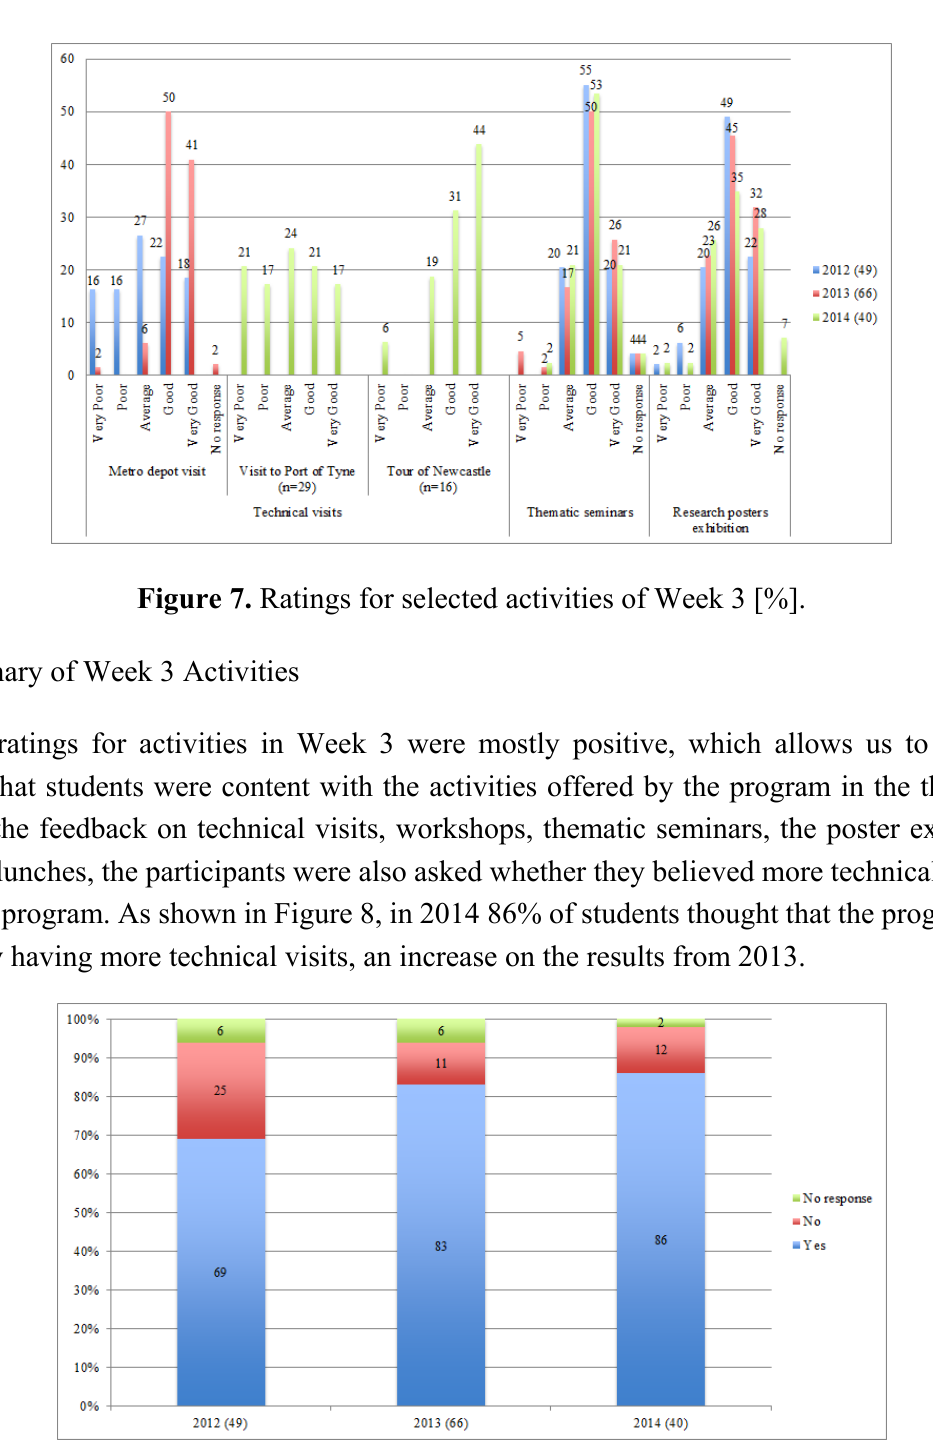
Figure 8. Would more technical visits improve the program?